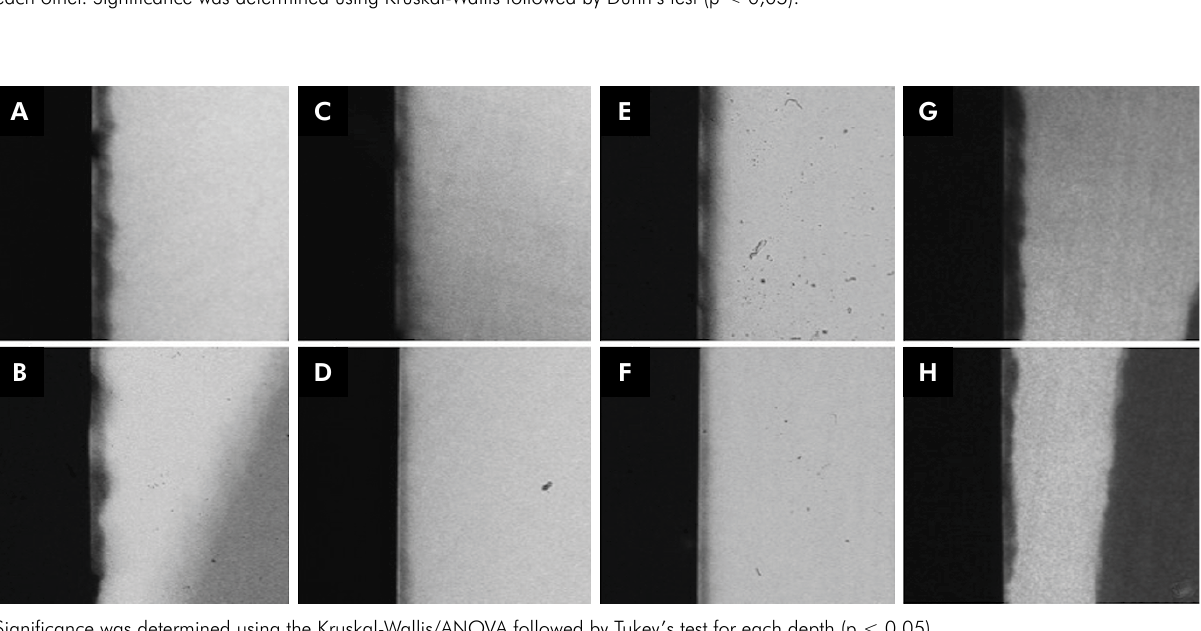
Effect of xylitol varnishes on enamel remineralization of immature teeth: in vitro and in situ studies